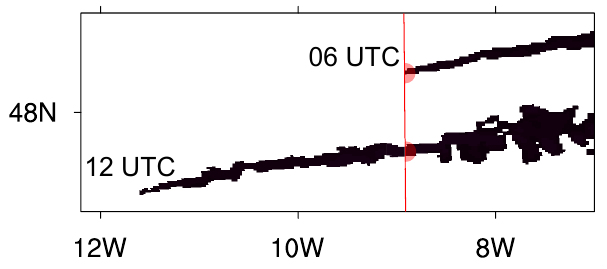
Figure 4. Schematic of selection method for plume points consid- ered for averaged size distributions shown in Fig. 3. Exemplary tracks are shown for 06:00 and 12:00UTC within the same map. The plume points are sampled at each level within a 10km radius (red half circle) at the latitude (red line) defined by the ship’s posi- tion at 06:00UTC. Therefore the plume points contain freshly emit- ted aerosol particles at 06:00UTC and atmospherically aged aerosol particles at